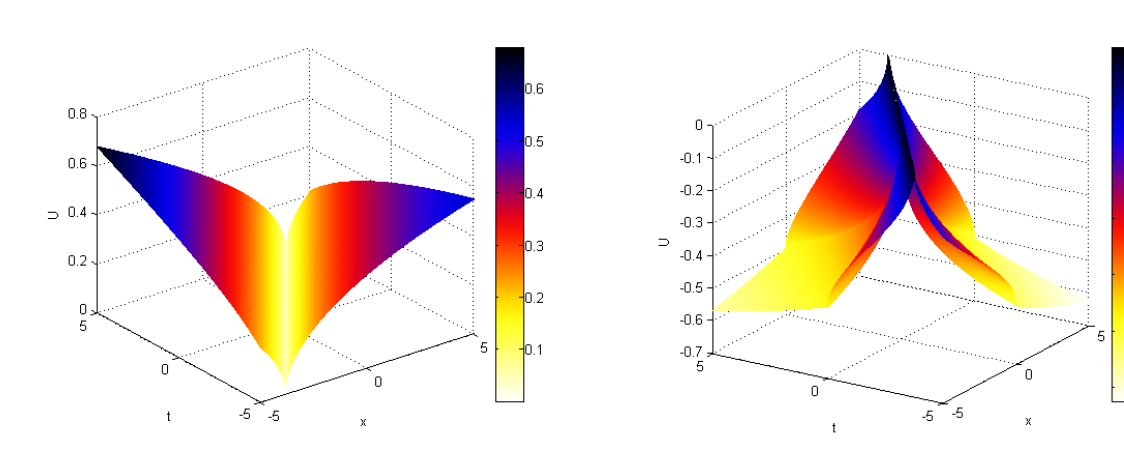
Fig. 4: The solution ˜ U 5 ( x , 0, 0, t ) in (4.17) for β =2.6, γ =-3.5, δ =3, l =- 2, α =0.5, µ =0, w = 3 and −5 ≤ t , x ≤ 5